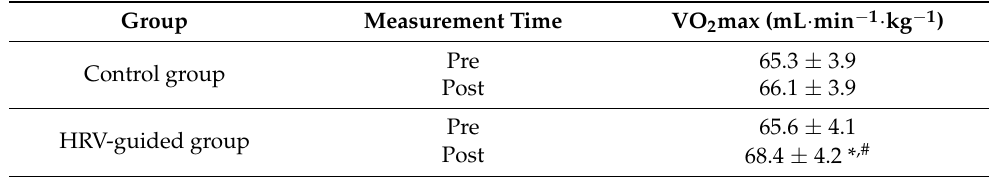
Figure 2. HRV compensation values measured during the 2-week altitude training camp. The VO 2 max values measured 3 days before and 8 days after the training camp in the HRV-guided training group and the control group are provided in Table 2. A significant group × time interaction ( p < 0.001) was driven by significant improvements in VO 2 max in the HRV-guided training group (+4.27%; p Bonf = 0.002) that were not observed in the control group (+1.26%; p Bonf = 0.643). Table 2. VO 2 max values before and after the training camp in the control and HRV-guided training groups.